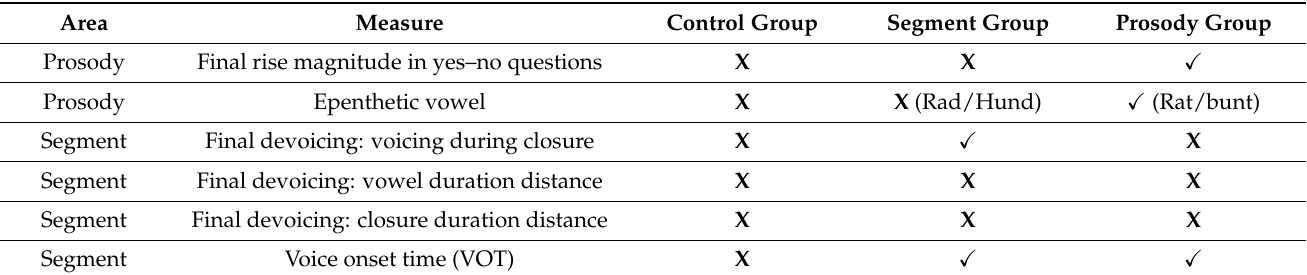
Table 14. Summary of